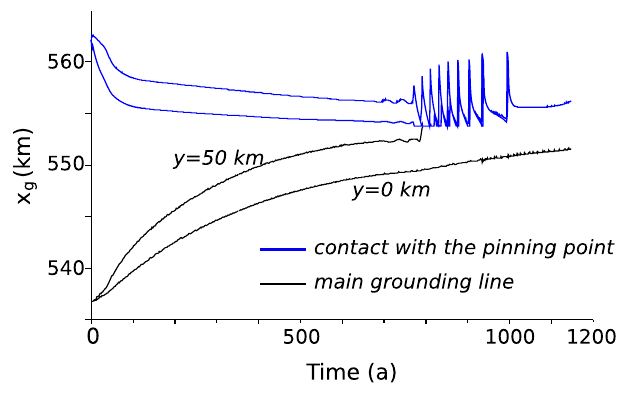
Fig. 10. Positions of grounding lines over time. The main ground- ing line is shown for y = 0 km and y = 50 km in solid black lines. The first and the last grounded points of the pinning point for y = 50 km are shown in solid blue